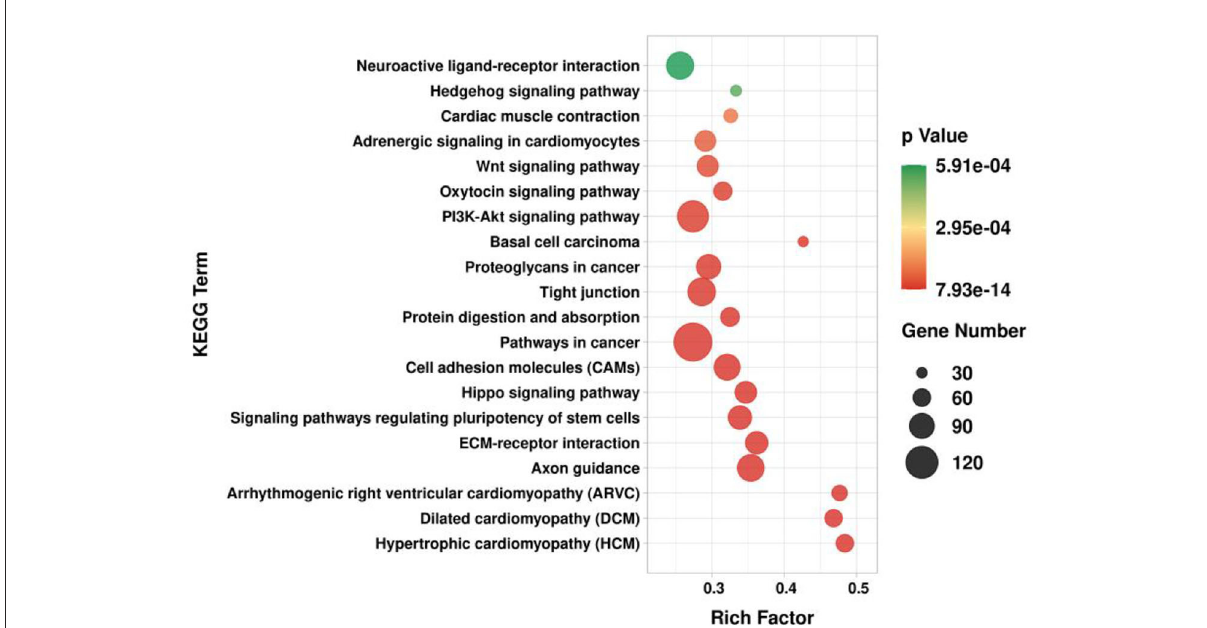
FIGURE13 KEGG enrichment analysis of target genes in lncRNA regulatory network of hair follicle development in Inner Mongolia cashmere goats. The X-axis is the rich factor, and the Y-axis is the KEGG